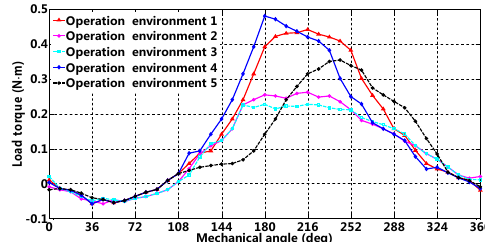
Figure 2. Load torque under different operating